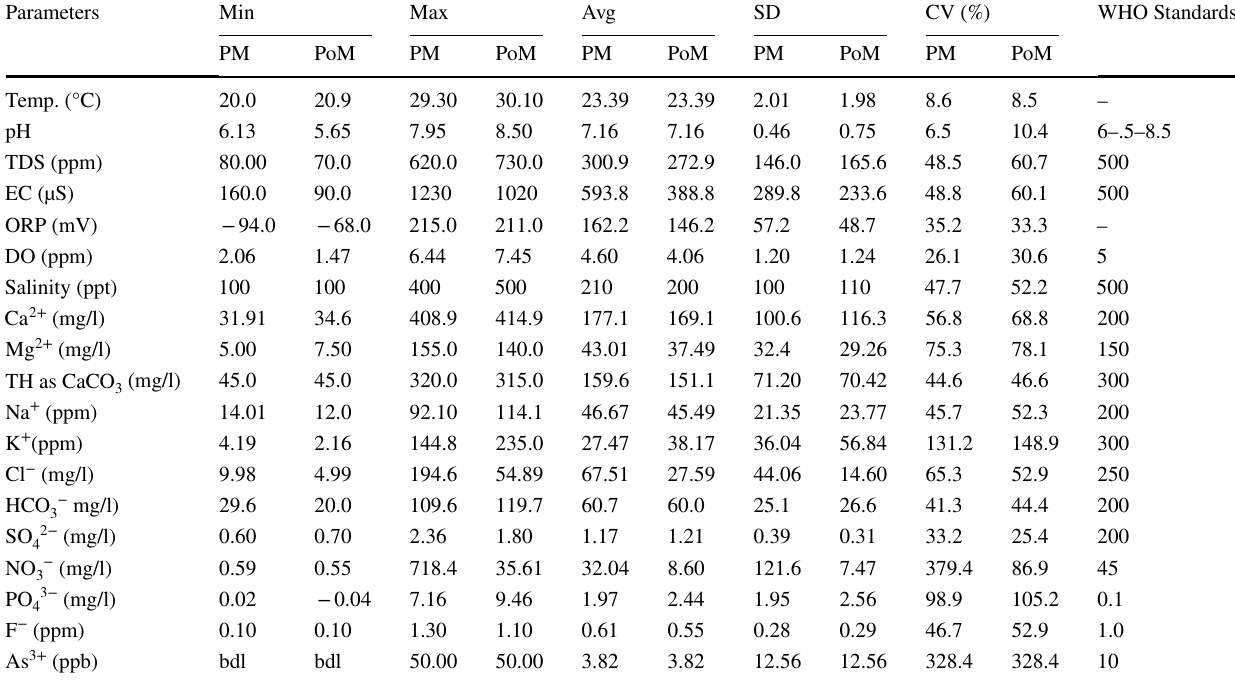
Table 1 The summary and descriptive statistics of the water quality parameters during PM and PoM seasons